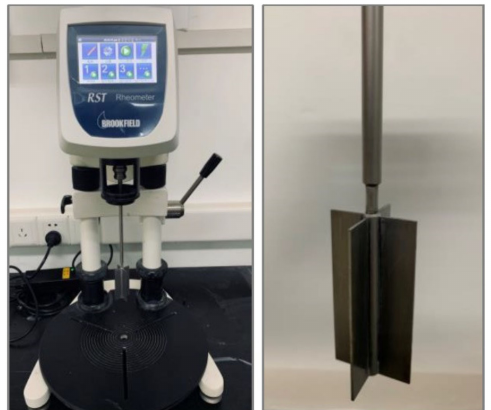
Figure 3. Rheological properties test of cement mortar.